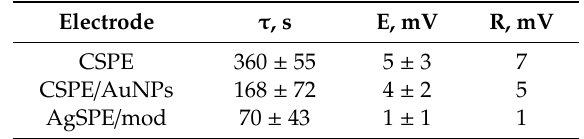
Table 1. Kinetics of stabilization and the values of the potential di ff erence between the same type of electrodes (n = 6, α = 0.05).